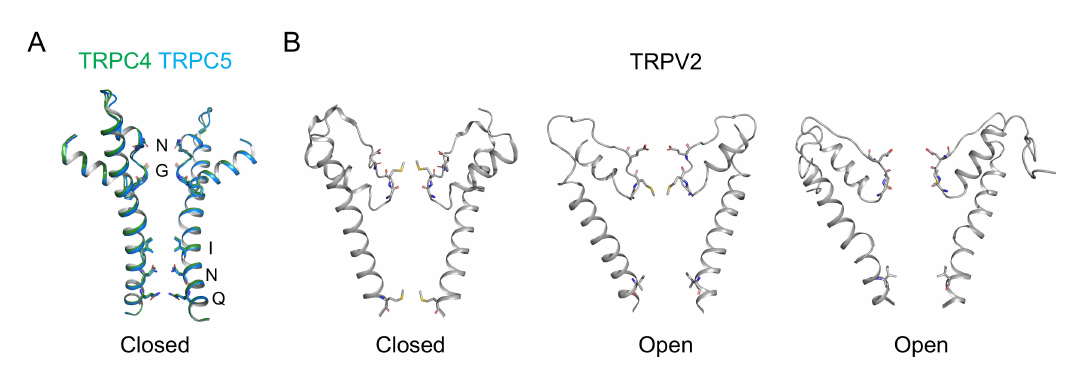
Figure 2. Putative pore models of TRPC4 and 5 channels based on conformation changes shown in TRPV2 channel. ( A ) Pore structure of TRPC4 (green) and TRPC5 (blue) channels. ( B ) Pore structure of TRPV2 channels. Left panel : closed state; Middle panel : open state with widened lower, helix-bundle-cross (HBC) gate; Right panel : open state with widened selectivity filter gate (SF gate) and HBC